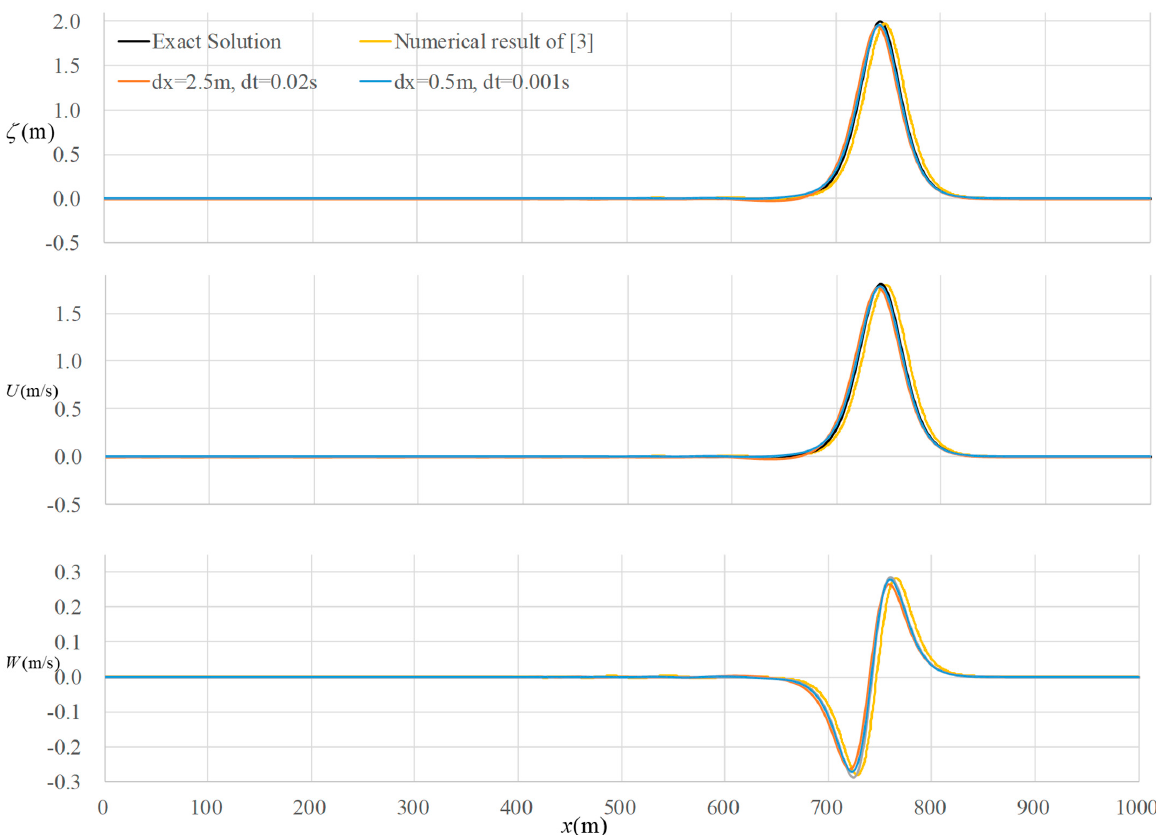
Figure 1. Comparison of the present numerical results with the exact solution and other numerical results of a solitary wave propagation in a constant depth.